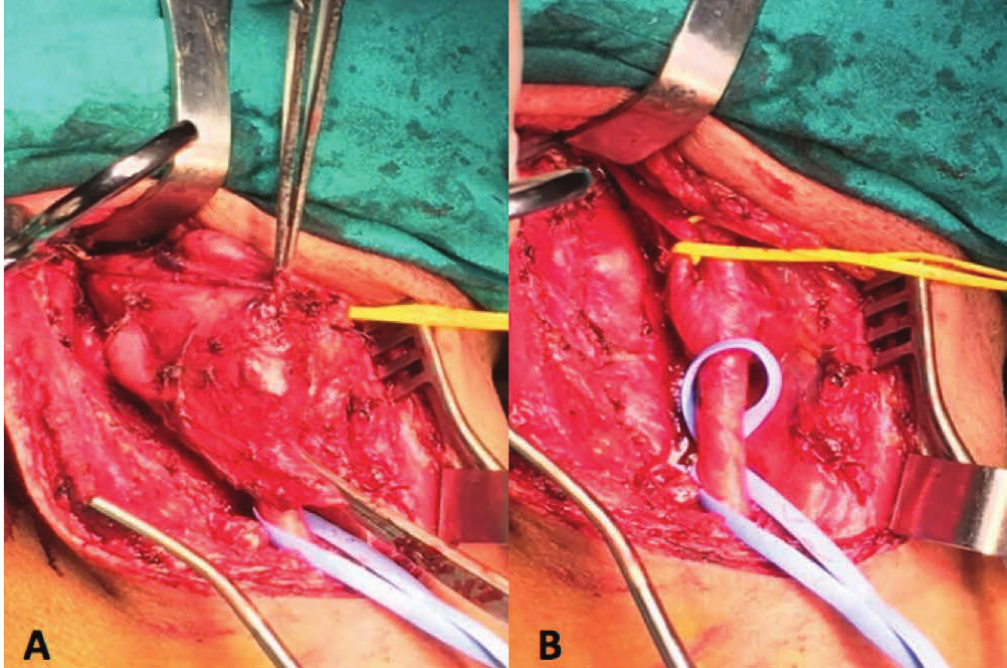
Figure 2: Intra-operative pictures during surgical excision of a CBT of PE-group (treated with Pre-operative Embolization ) : A) pre-excision; B)